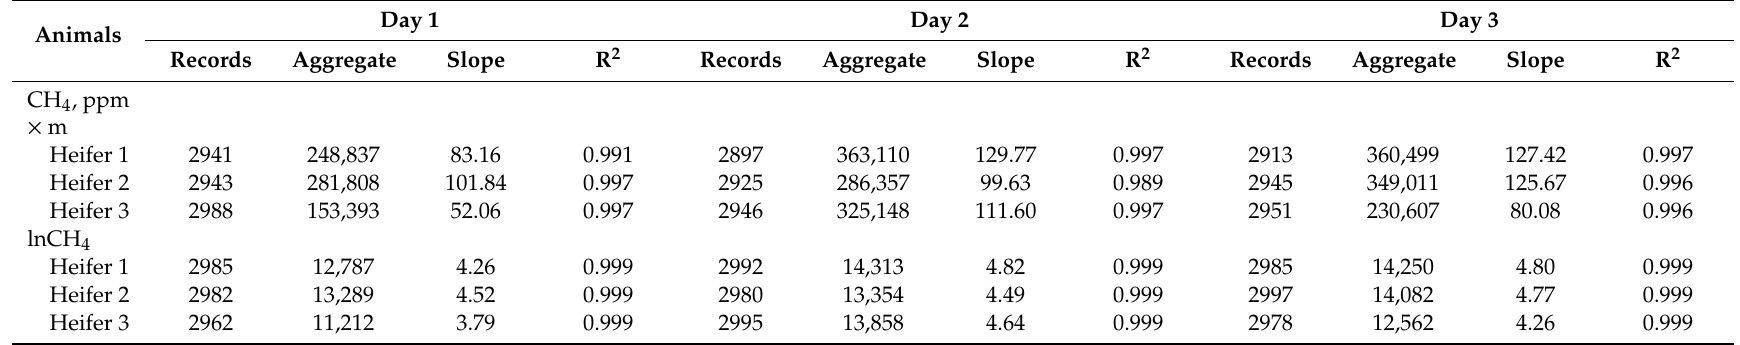
Table 3. Number of records, aggregate value, slope, and coe ffi cient of determination (R 2 ) of the linear model calculated within the day on five measurements for methane (CH 4 ) and log e -transformed methane (lnCH 4 )